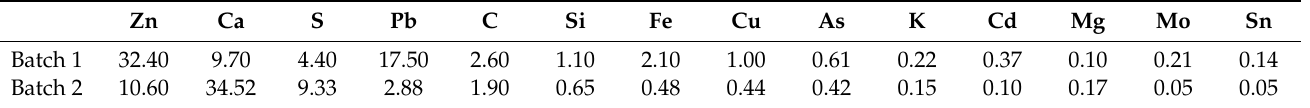
Table 4. Chemical composition of the two electric furnace flue dust batches (wt.%).